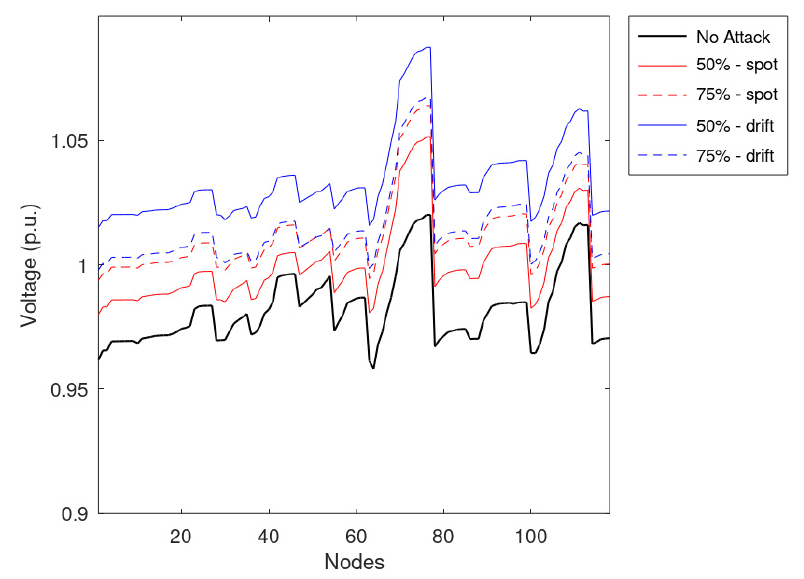
Figure 11. Average voltage of the nodes, assuming that 50 and 75% of measurements are manipulated.